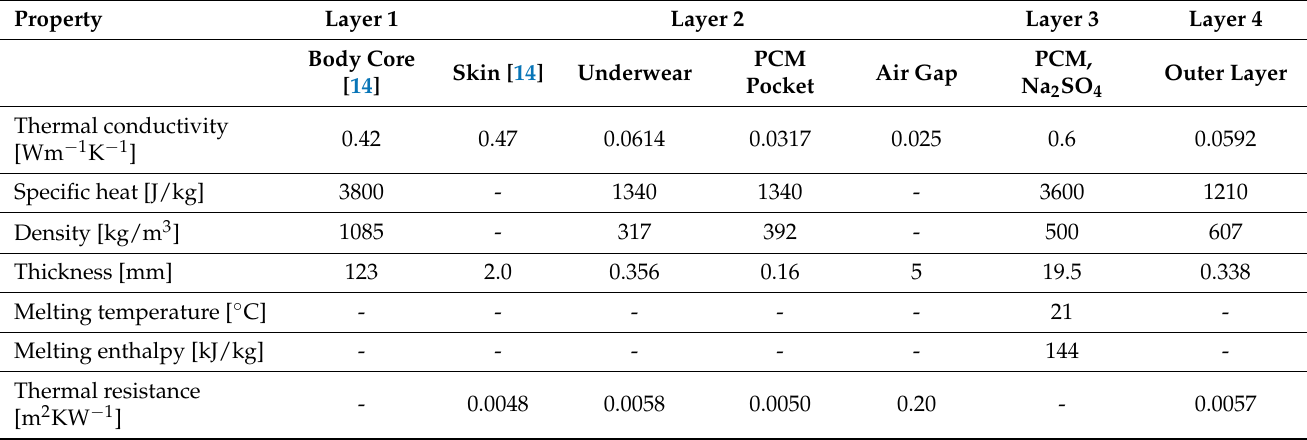
Table 1. Thermal properties used as input for human PCM cooling model. Data from [23] unless indi- cated otherwise. Thermal resistances are calculated as the ratio of thickness and thermal conductivity.